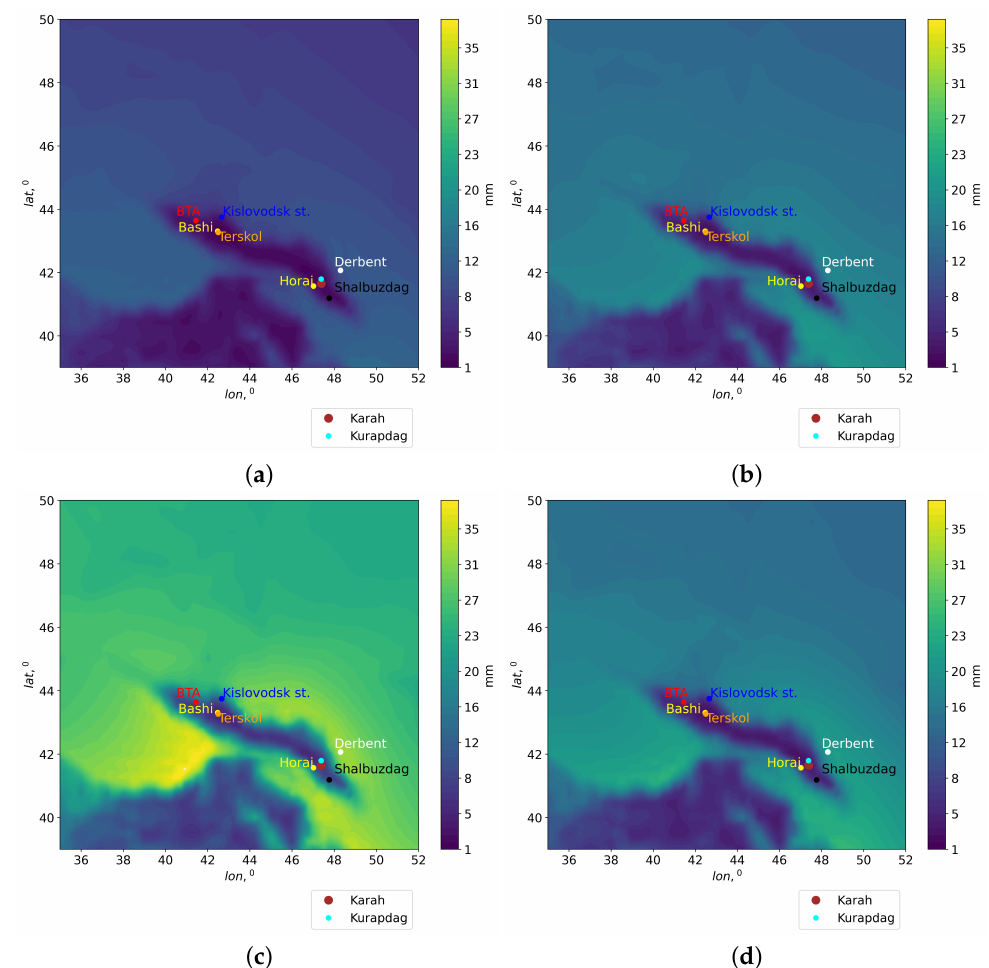
Figure 6. Era-5 PWV spatial distributions obtained for the period 2010–2020, adapted for mountain peaks: ( a ) winter; ( b ) spring; ( c ) summer; ( d )